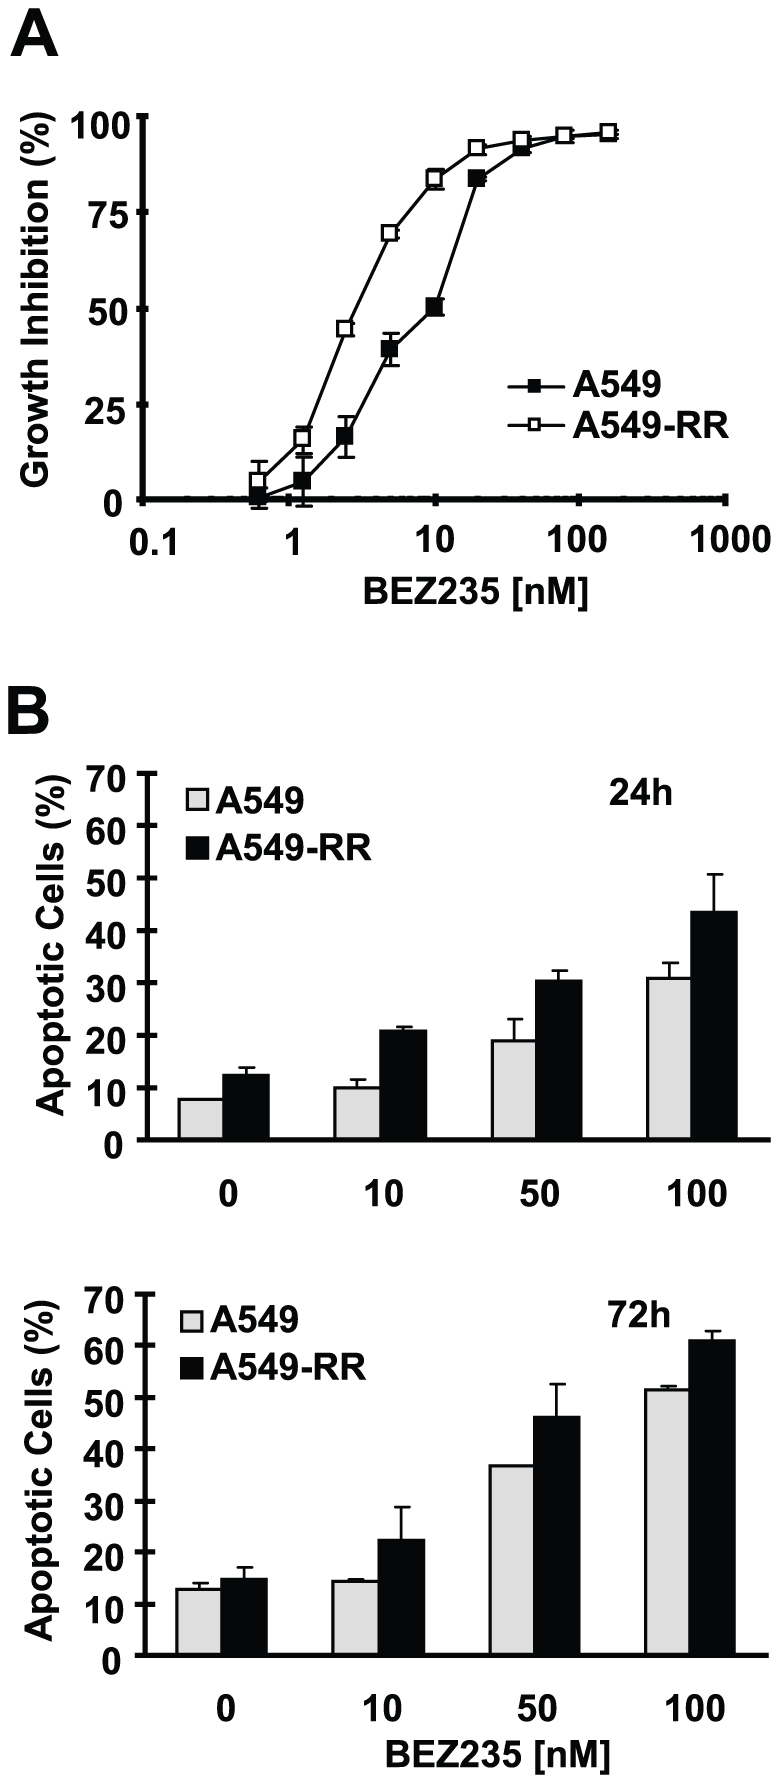
BEZ235 is effective in inhibiting the growth (A) and inducing apoptosis (B) of rapamycin-resistant cells.
A, The indicated cell lines were seeded in 96-well plates and then treated with different concentrations of BEZ235 as indicated on the second day. After 3 days, the cell numbers were estimated using SRB assay. Points, means of four replicate determinations; bars, ± SD. B, The indicated cell lines were plated in 6-well plates and then treated next day with different concentrations of BEZ235 as indicated. After 24 and 72 h, the cells were harvested and subjected to detection of apoptosis using Annexin V staining. Columns, means of duplicate determinations; bars, ± SD.